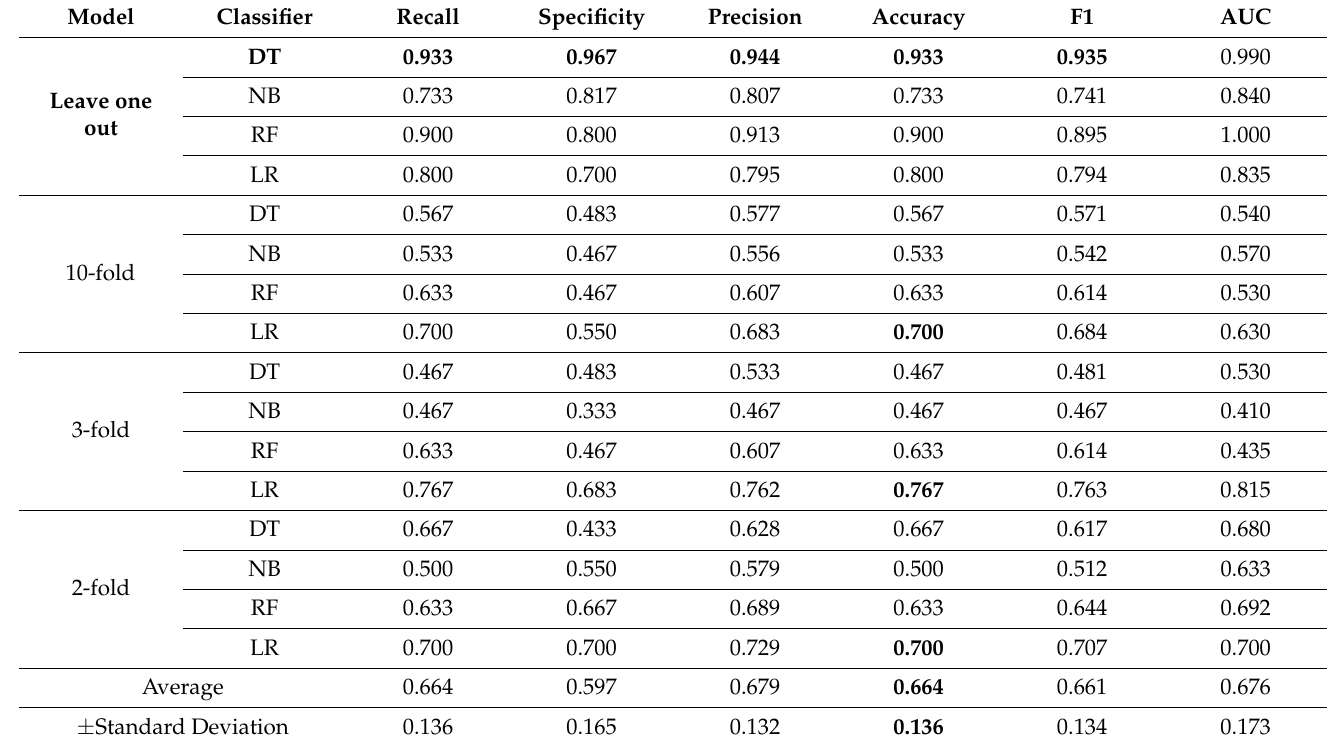
Table 2. Performance of the intra-subject (mental stress and normal) classification using nine features, including AHR, MRR, and seven HRV